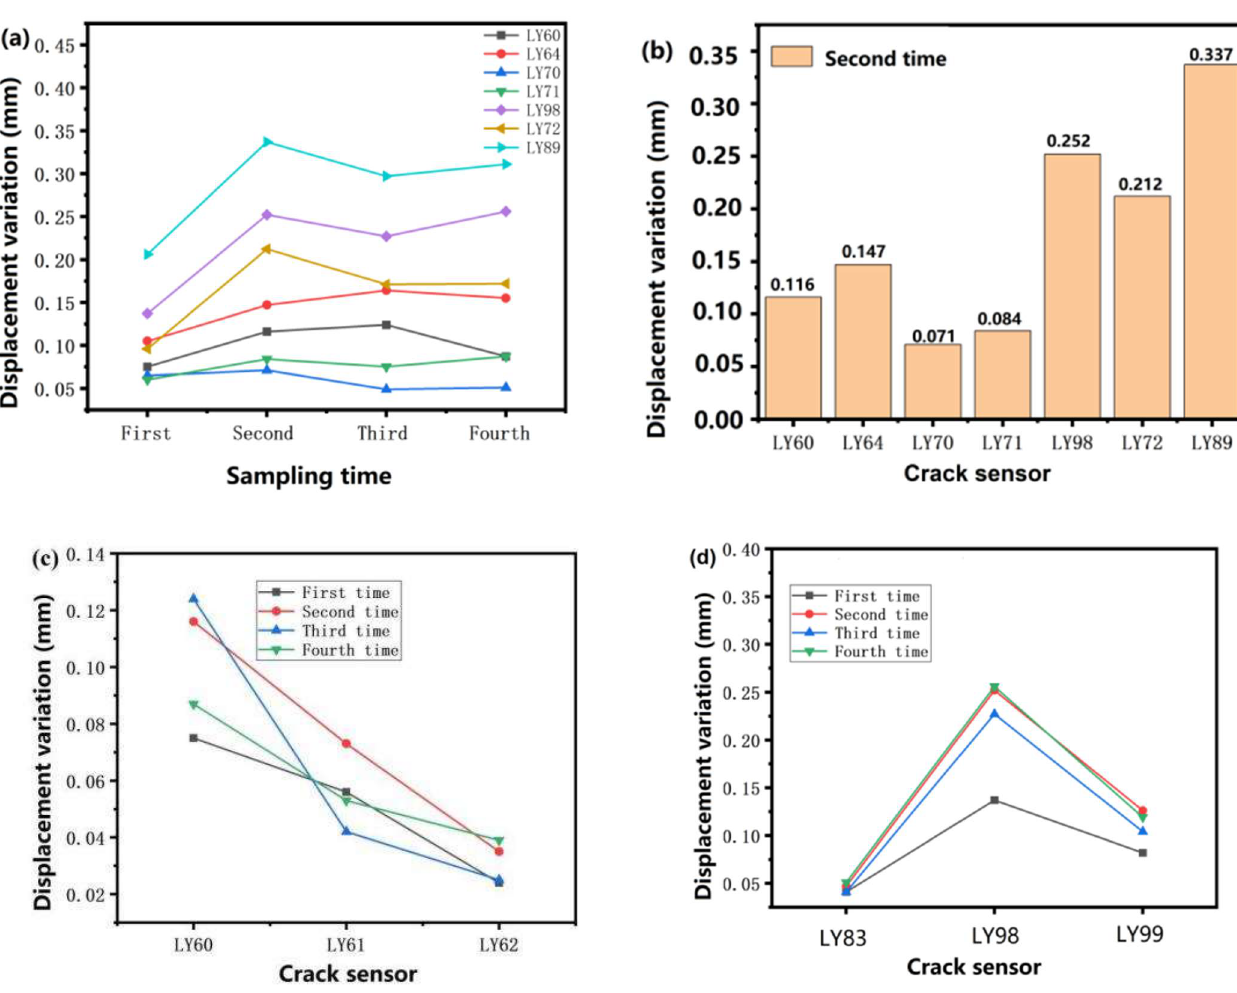
Figure 12. ( a ) The maximum variation of crack propagation displacement of the miter gate at the different positions as time; ( b ) the displacement variation of the cracks at different locations in the second time sampling; ( c ) No. 1 crack and ( d ) No. 5 crack displacement variation in four time sampling.